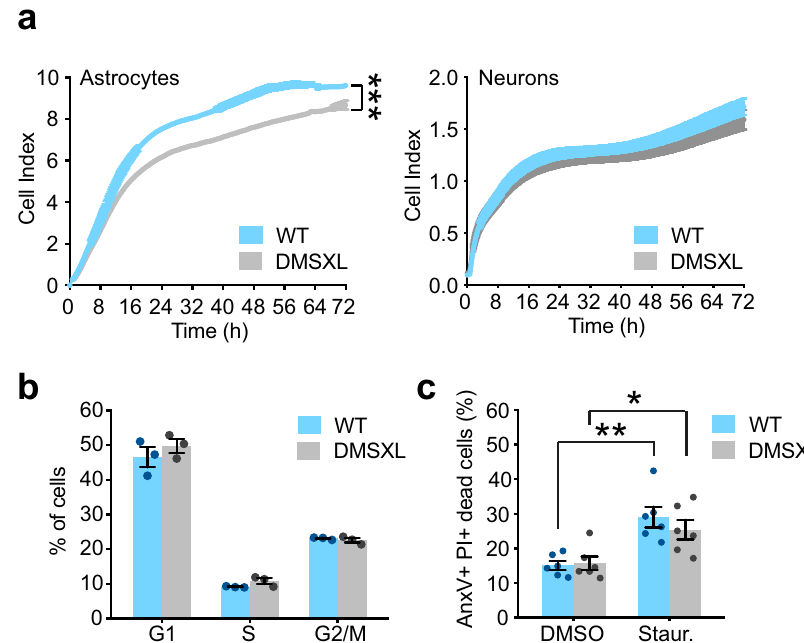
Fig. 2 Primary DMSXL astrocytes display abnormal population dynamics. a xCELLigence cell index of primary astrocytes and primary neurons over 72 h. Data are mean ± SEM, n = 6 independent cultures per group, each one established from a different animal ( p < 0.0001, Two-way repeated measures ANOVA). b Percentage of DMSXL and WT astrocytes in G1, S, and G2/M phases of the cell cycle by FACS analysis of DNA content (PI levels) and DNA synthesis (BrdU incorporation). Data are mean ± SEM, n = 3 independent cultures per genotype. c FACS analysis of DMSXL and WT astrocyte cell death under control conditions (DMSO) and in the presence of Staurosporine (Staur). Percentage of apoptotic cells labeled with annexin V (AnxV + ), and necrotic cells labeled with propidium iodide (PI + ). Data are mean ± SEM, n = 6 independent cultures per genotype ( p = 0.0043, WT; p = 0.0240, DMSXL; Two-way ANOVA and Sidak post hoc test for multiple comparisons). Source data are provided as a Source Data fi le. * p < 0.05; ** p < 0.01; *** p <